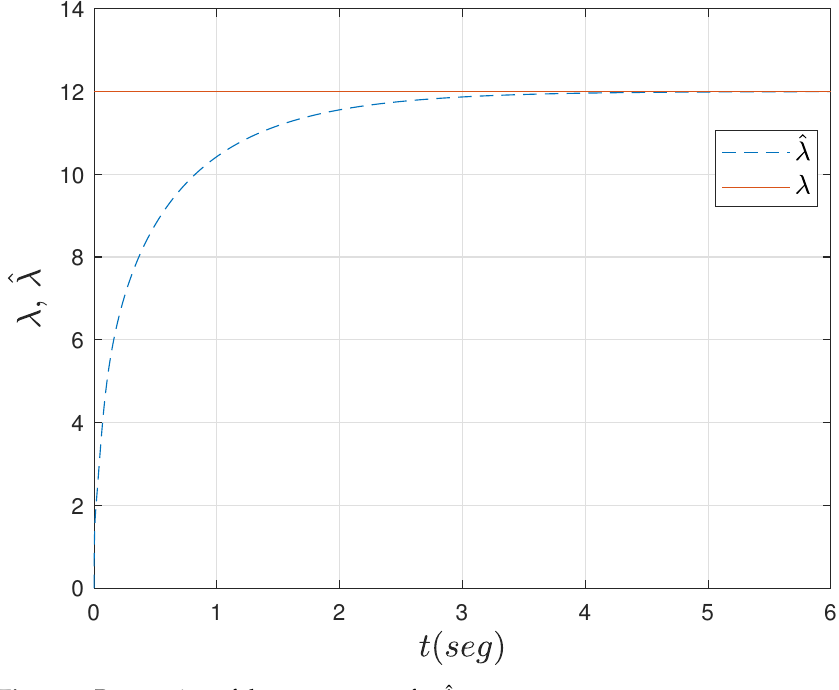
Figure 6. Progression of the convergence for ˆ λ .